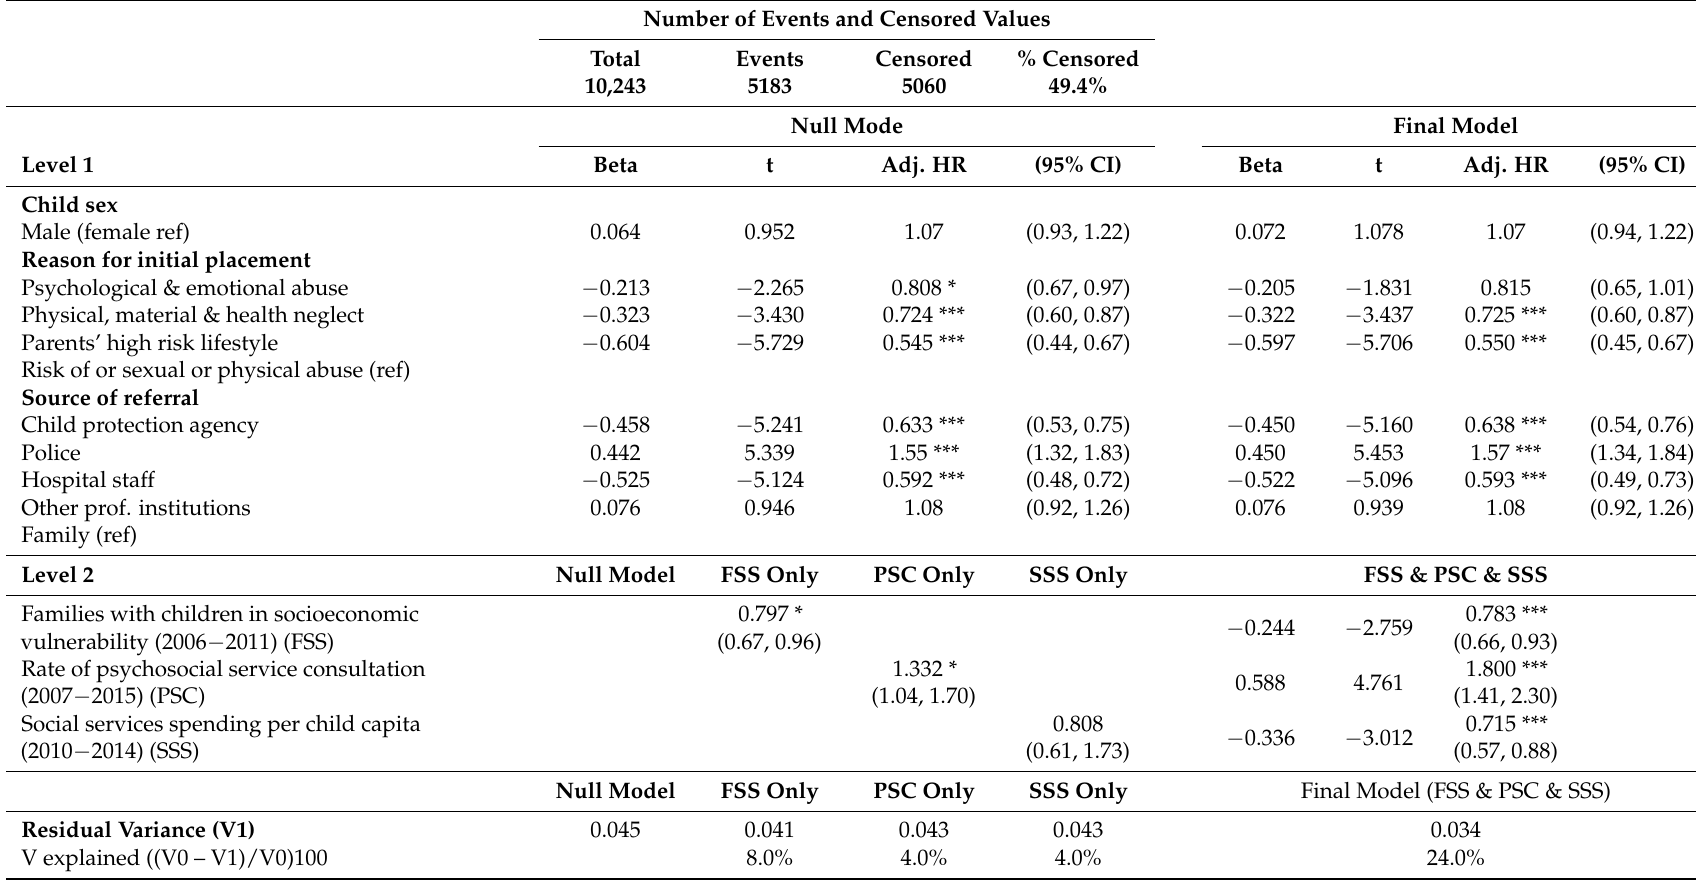
Table 3. Multilevel Cox proportional hazard model of family reunification for placed children age 0 to 4